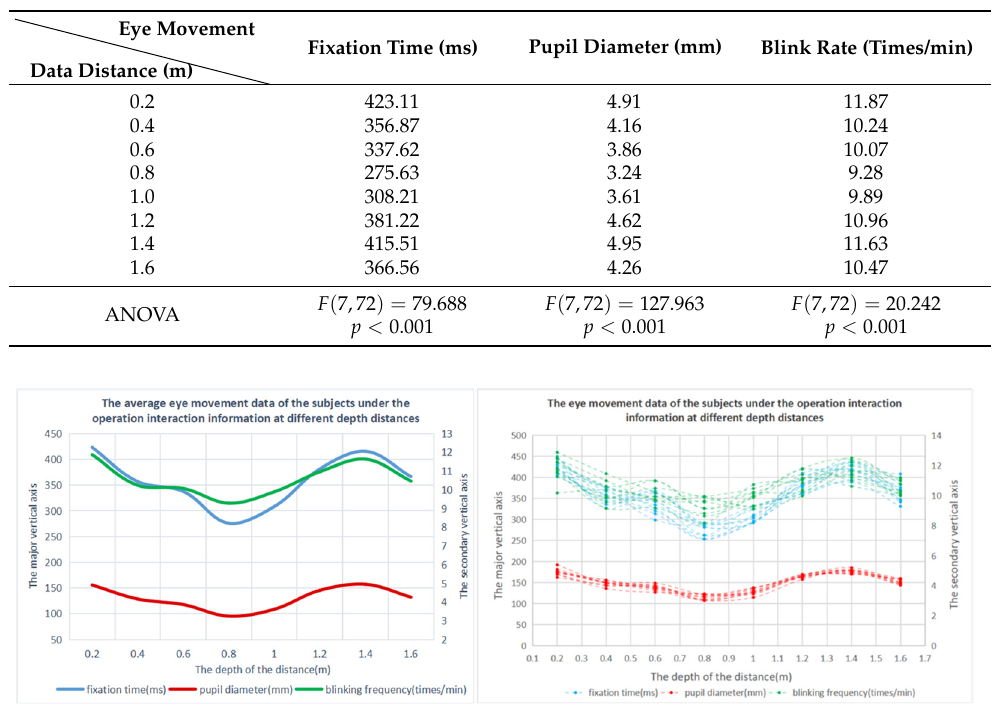
Table 5. Average eye movement data after dividing the depth and distance range of operation in- teraction information.